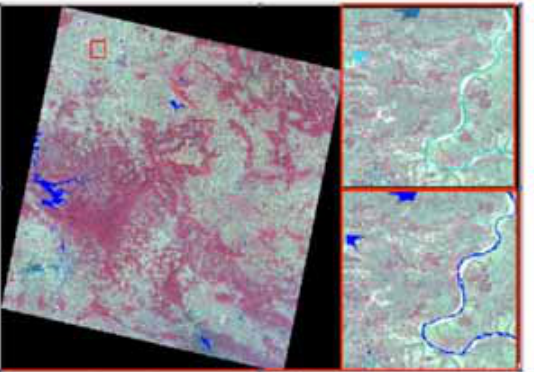
Figure 7 shows the FCC image of the scene and the classified image for post monsoon water spread along with the insert showing the expanded image of a small portion of the image